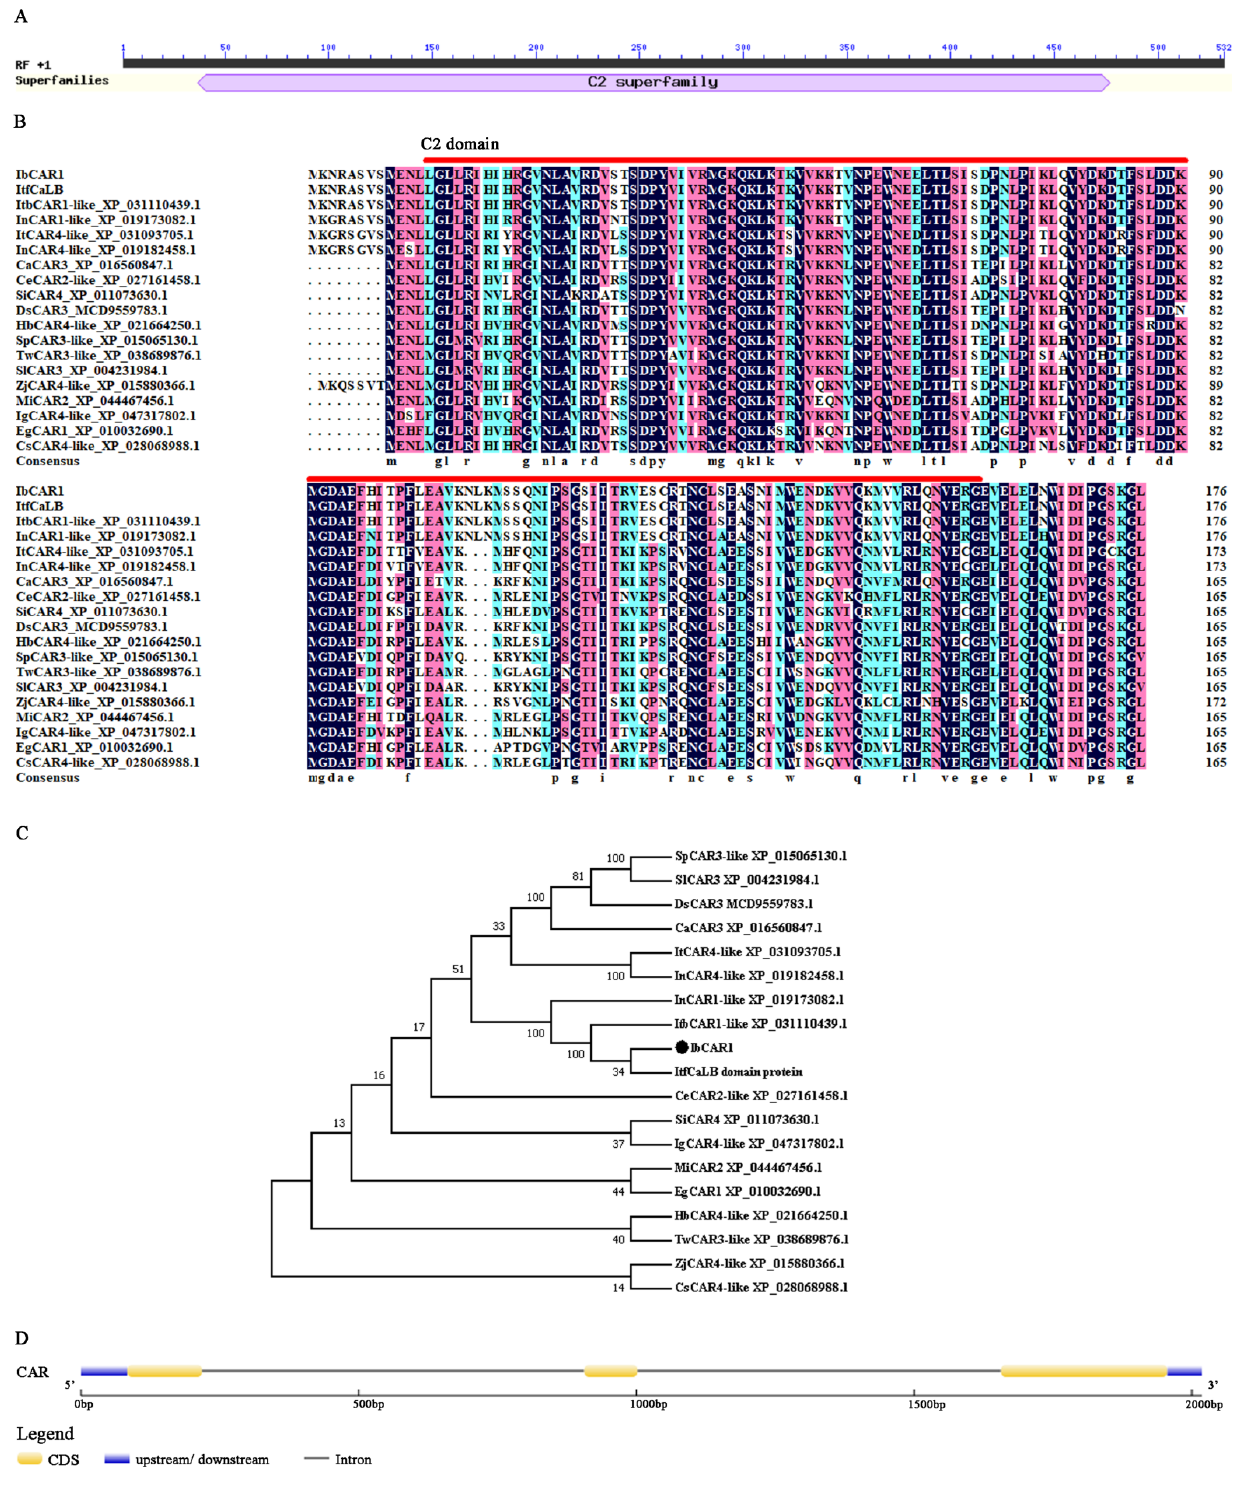
Figure 1. Sequence analysis of IbCAR1. ( A ) Features of IbCAR1 protein. ( B ) Sequences alignment of IbCAR1 with its closest homologs from other species. The C2 domain is represented with red lines. ( C ) Analysis of IbCAR1 protein homology tree in different species. ( D ) The structure diagrams of IbCAR1. Exons are represented by ellipses, and introns are represented by lines. The blue boxes represent the 5 (cid:48) and 3 (cid:48) untranslated regions